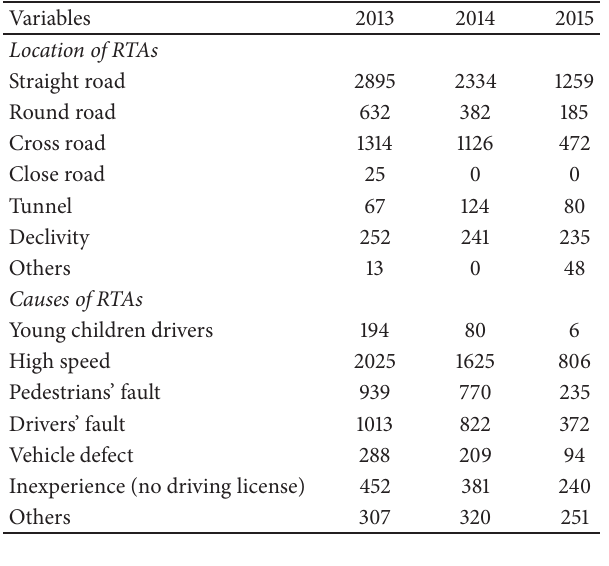
Table 3: Distribution of location and causes of RTAs ( 𝑁 = 11684 ).